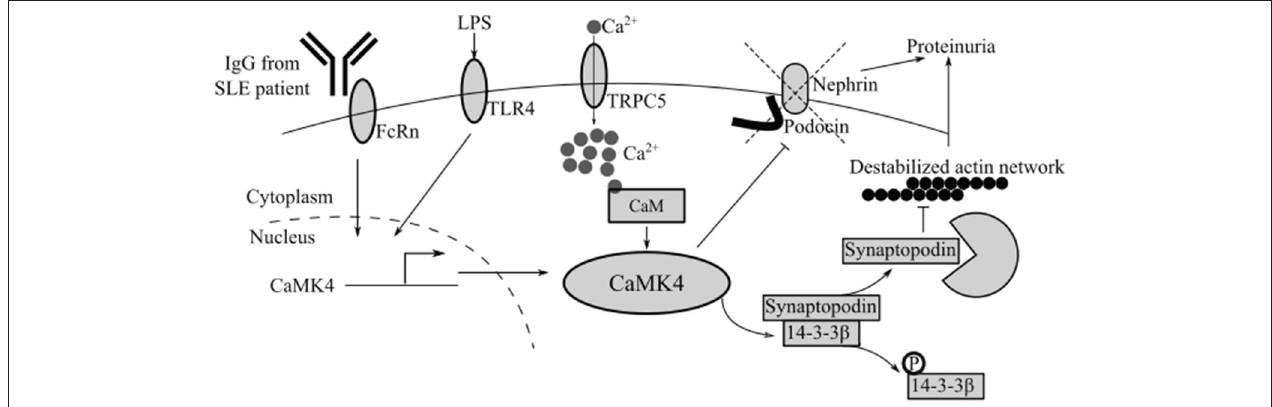
FIGURE 2 | CaMK4 contributes to podocyte dysfunction in autoimmune and non-autoimmune kidney disease. Multiple stimuli including IgG from SLE patients or LPS upregulate CaMK4 leading to destabilization of the actin network and downregulation of nephrin and podocin. TRPC5, short transient receptor potential channel 5.